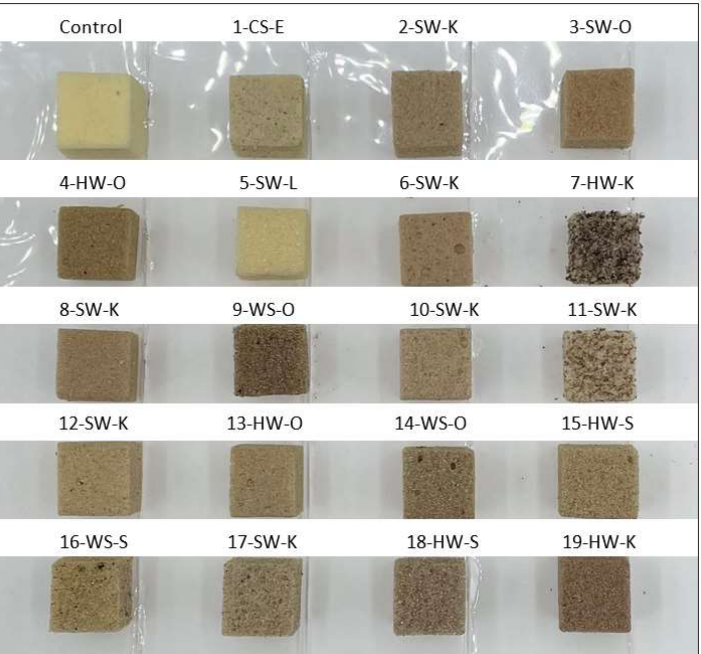
Figure 3. Images of lignin-based (30 wt.%) and control foams. Samples 3-SW-O, 7-HW-K, and 11-SW-K failed the compression strength and/or closed-cell content tests.